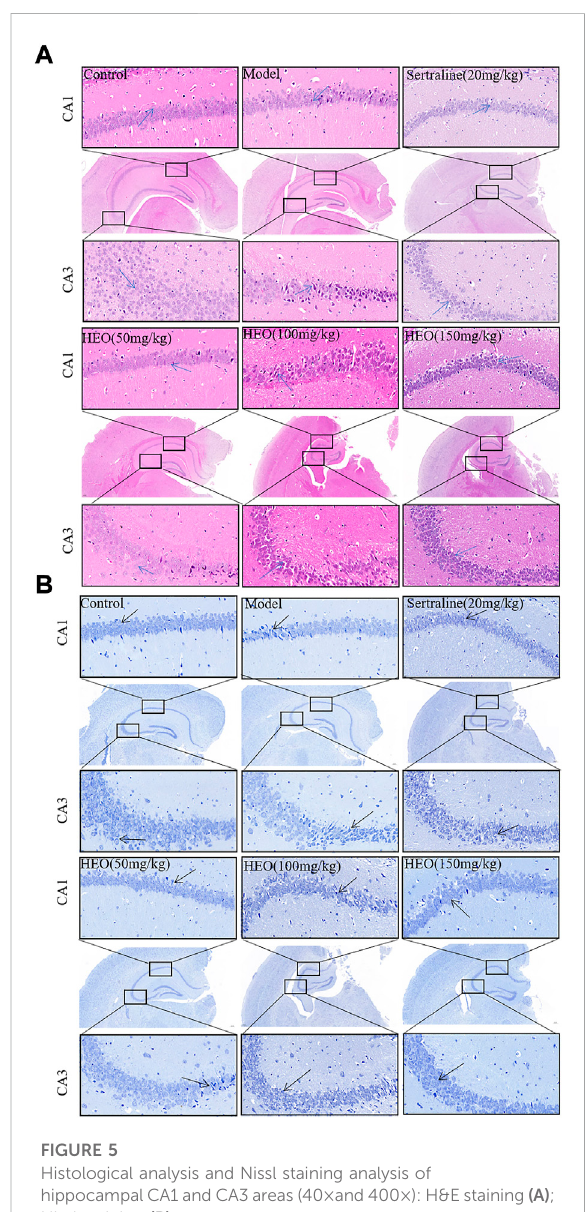
FIGURE 5 Histological analysis and Nissl staining analysis of hippocampal CA1 and CA3 areas (40×and 400×): H&E staining (A) ; Nissl staining (B)